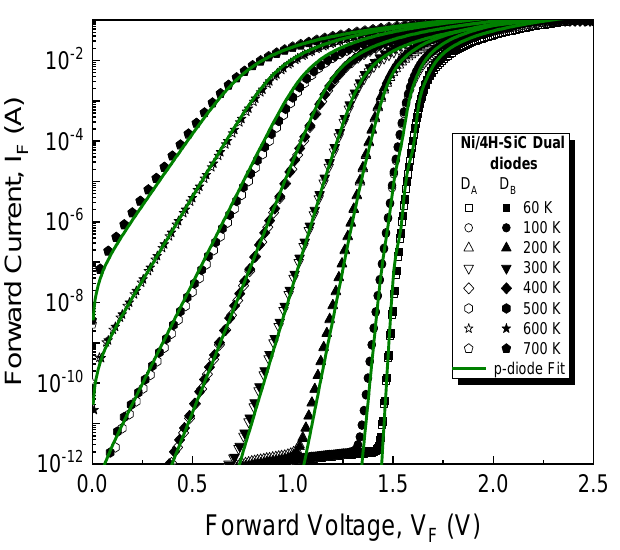
Figure 4. Forward I-V characteristic for the dual SiC Schottky diodes. Measurement data (symbols) and their p-diode model-fitted counterparts (lines). and their p-diode model-fitted counterparts (lines).